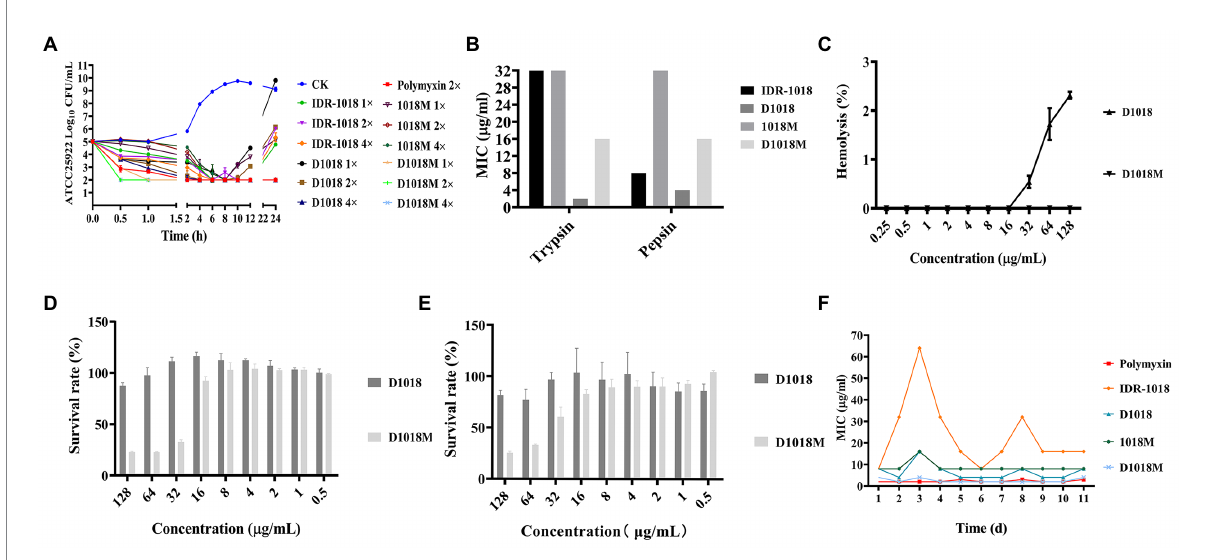
FIGURE 1 The killing curves, stability, toxicity and resistance of peptides. (A) The killing curves of IDR-1018, D1018, 1018M, and D1018M. (B) The protease stability of IDR-1018, D1018, 1018M, and D1018M. (C) The hemolysis of D1018 and D1018M. (D) The cytotoxicity of D1018 and D1018M against RAW264.7 cells. (E) The cytotoxicity of D1018 and D1018M against Vero cells. (F) The resistant of E. coli ATCC25922 against IDR-1018, D1018, 1018M, and